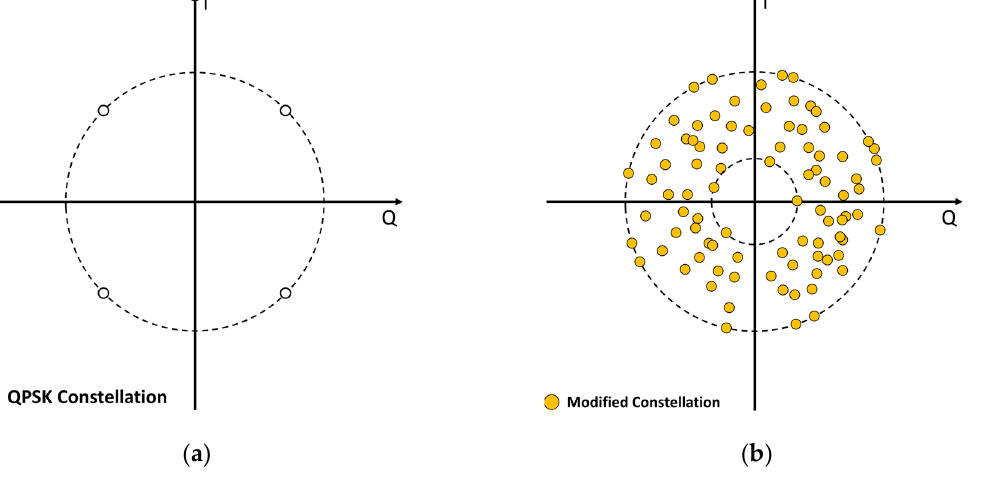
Figure 2. I/Q constellation ( a ) before signaling process and ( b ) after ring-shaped signaling